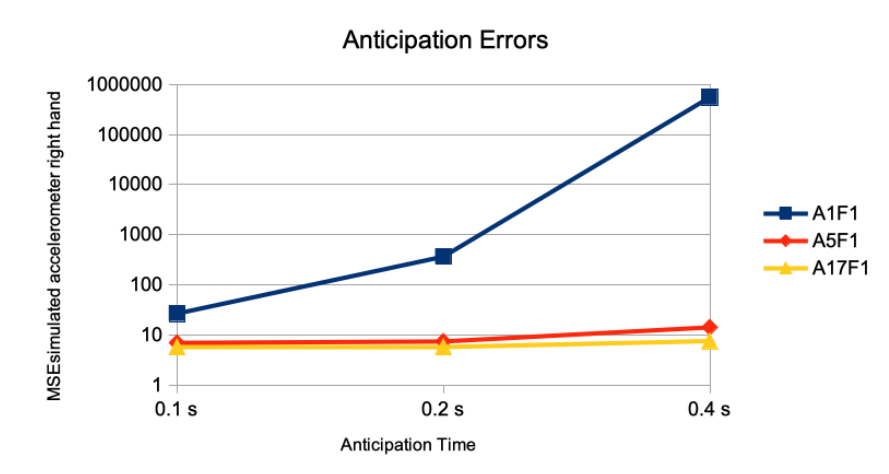
Figure 4. Single marker acceleration anticipation without and with spatial context. The anticipation errors of 0.1s (5 frames), 0.2s (10 frames), and 0.4s (20 frames) are given for the anticipation of simulated accelerations of the marker of the right hand joint using no spatial context (M1F1), all end effector markers and the root position as spatial context (M5F1), and all 17 markers as spatial context (M17F1). The error measure is the average of the mean squared error on the accelerations marker sequences of the right hand joint on the different motion classes of the Human 3.6M dataset for actor #5. Notice that the error is given in logarithmic